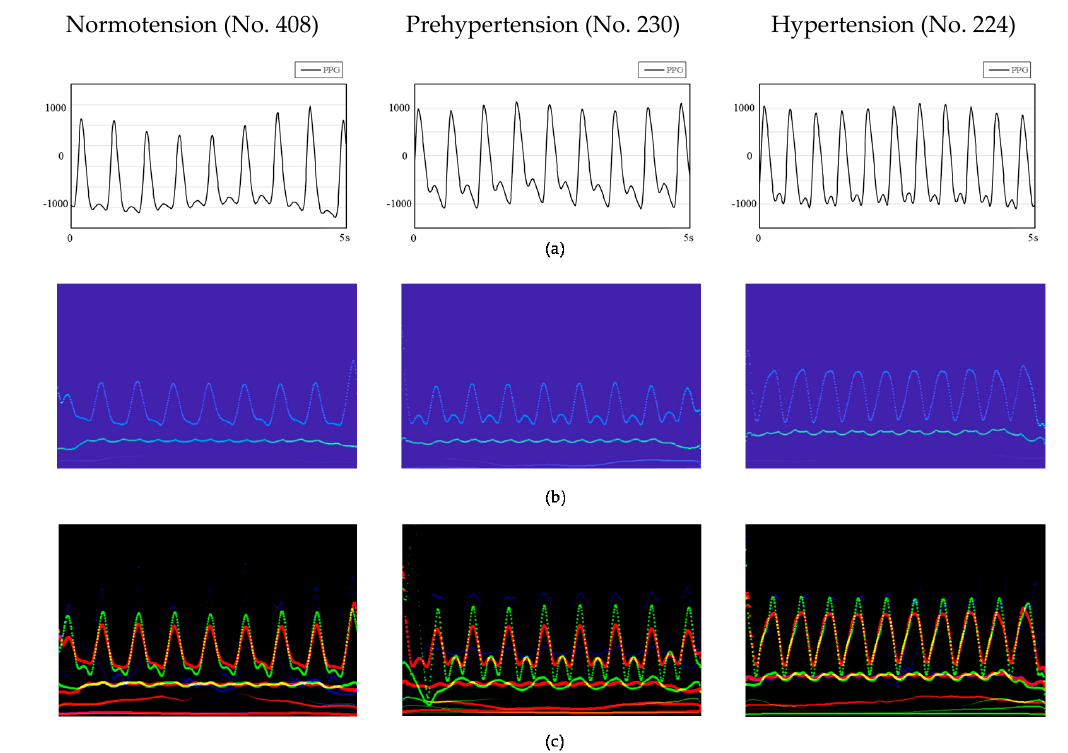
Figure 4. HHT spectrograms of three patients in different time periods. ( a ) PPG signals. ( b ) HHT spectra of PPG signals. ( c ) RGB images of PPG and its first and second derivative (PPG+) spectrogram combination. No. 408, No. 230 and No. 224 are the numbers of the patients.